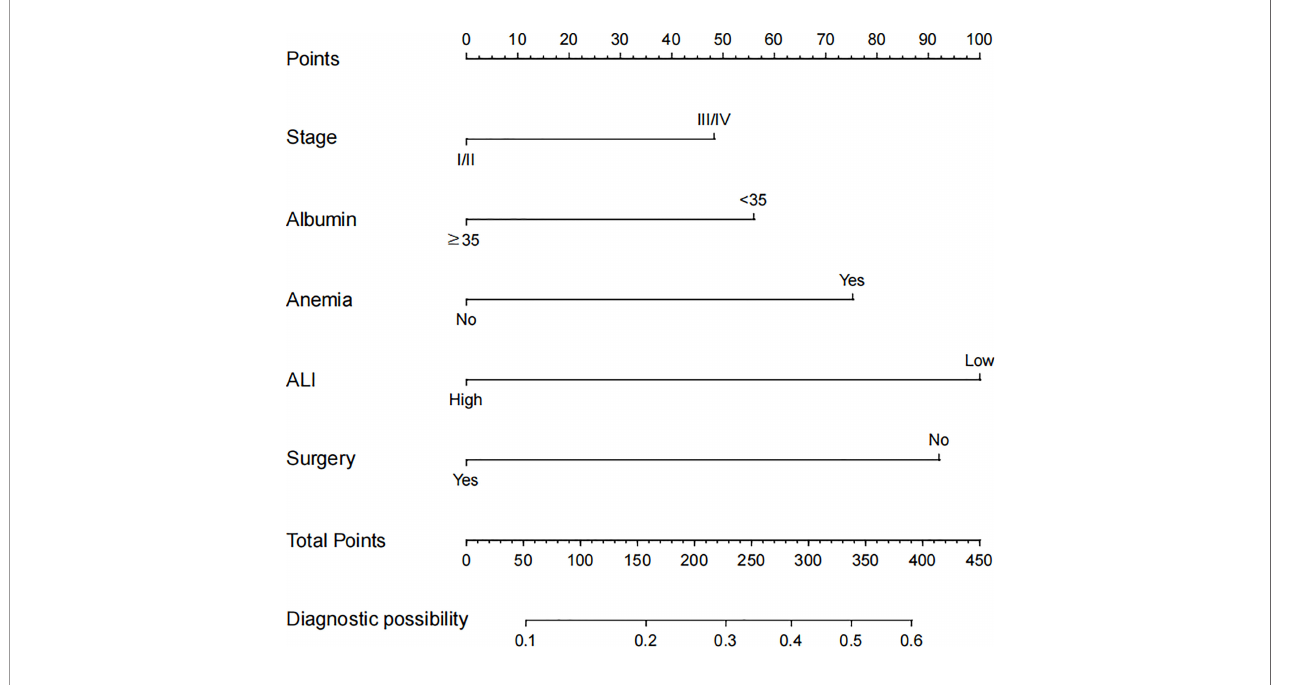
FIGURE 2 | Nomogram for predicting the risk of cancer cachexia in lung cancer patients.